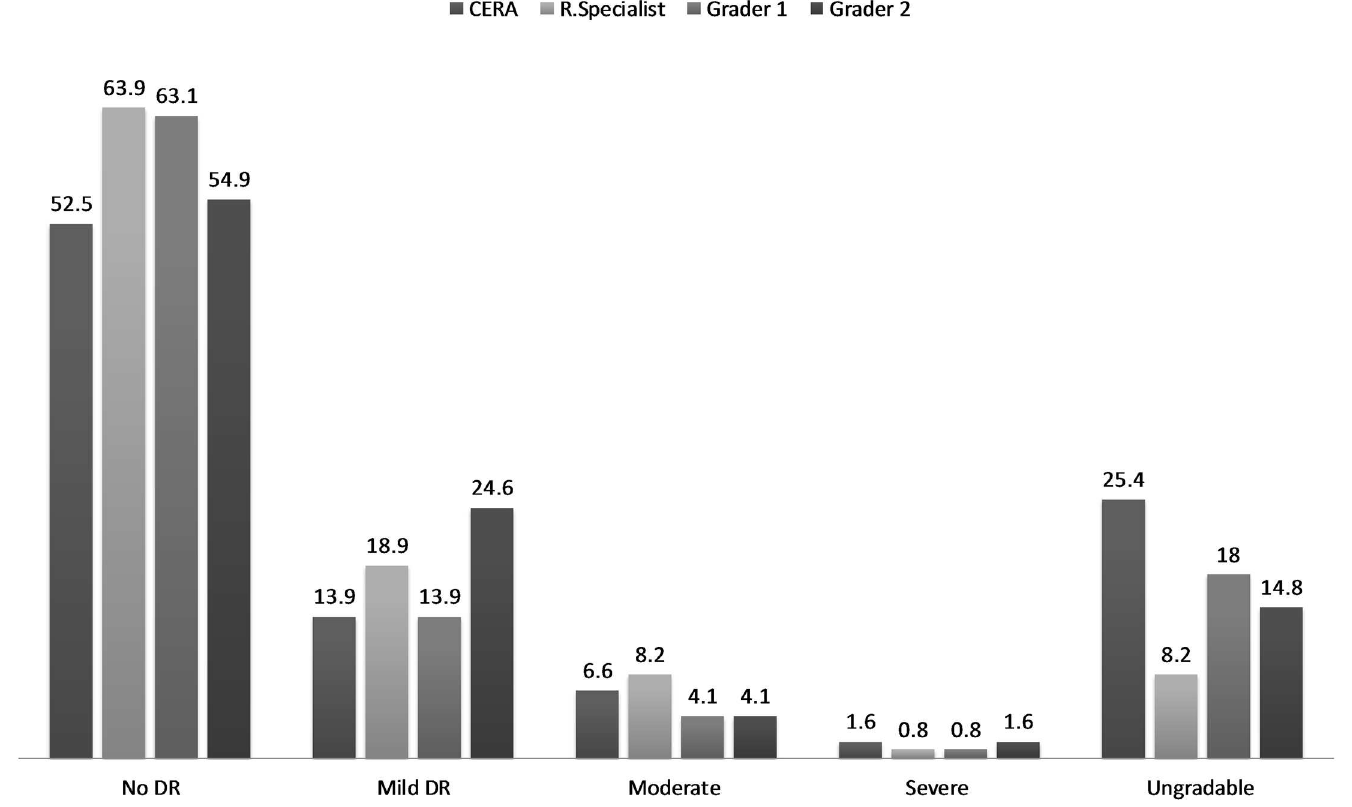
Fig 1. DR (%) graded by CERA grader, retinal specialist (R. Specialist) and the local graders (Grader 1 and Grader 1).